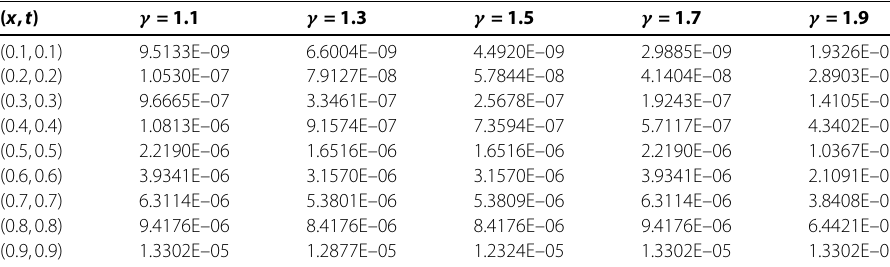
Table 5 Absolute errors of Example 2 for many values of γ at different points ( x , t